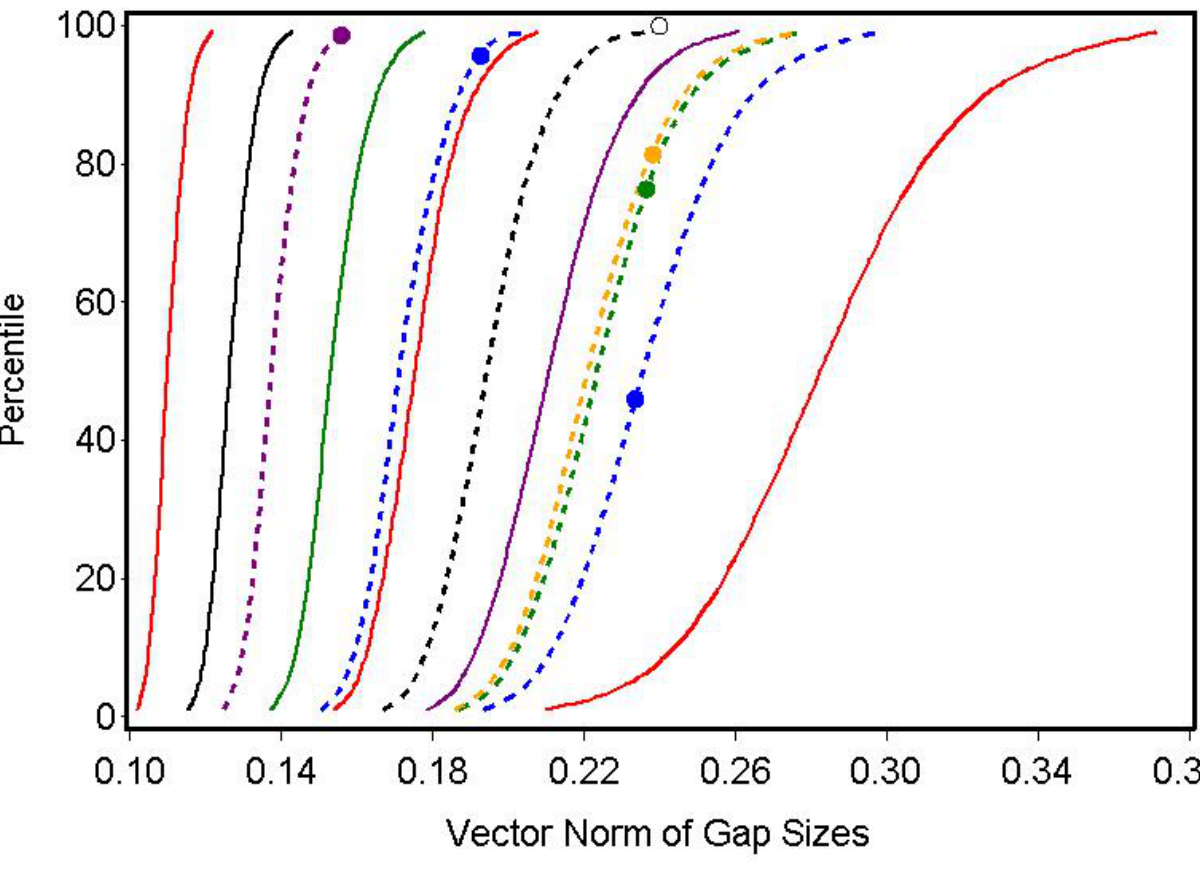
Fig. 3. Discontinuity index based on vector norm of gap sizes. Solid lines (left to right) represent sample sizes of n = 160, 120, 80, 60, 40, and 20. Dashed lines (left to right) represent example data sets with n = 101 (boreal forest birds), n = 63 (firm data SIC 226), n = 48 (SW cities 1890), n = 36 (boreal forest mammals), n = 35 (Everglades mammals), and n = 31 (Mediterranean mammals). Dots on dashed lines depict where the example data set vector norm is located on the